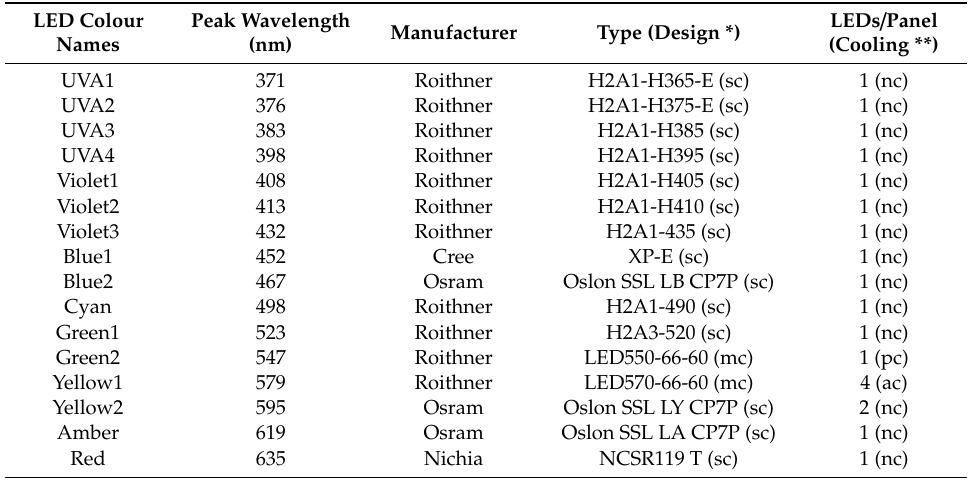
Table 1. Specifications of high-power light-emitting diodes (LEDs) and constructed panels